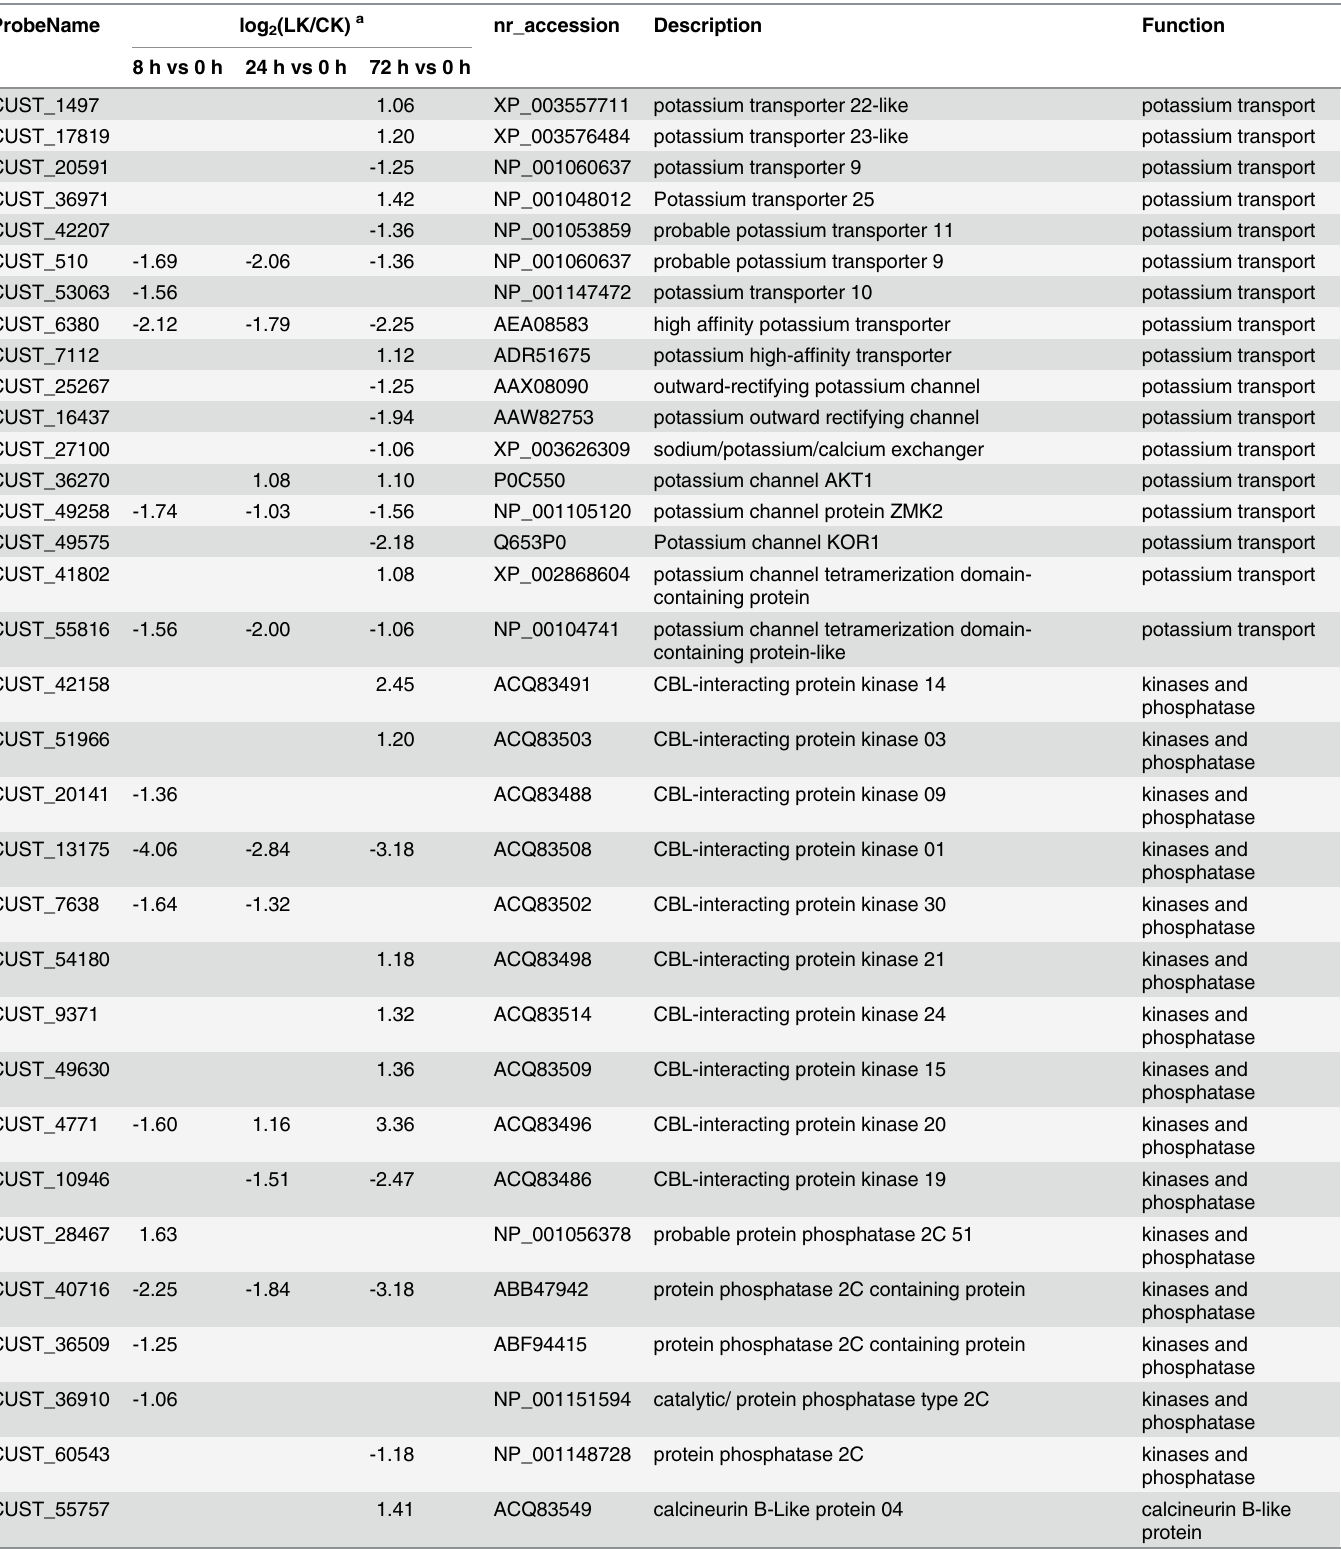
Table 1. Genes showing altered expression in sugarcane under low-K